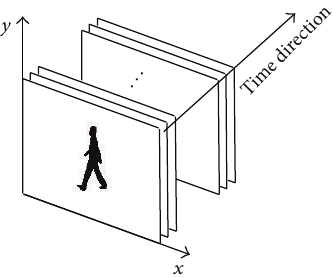
Figure 2: Three dimensions of the original